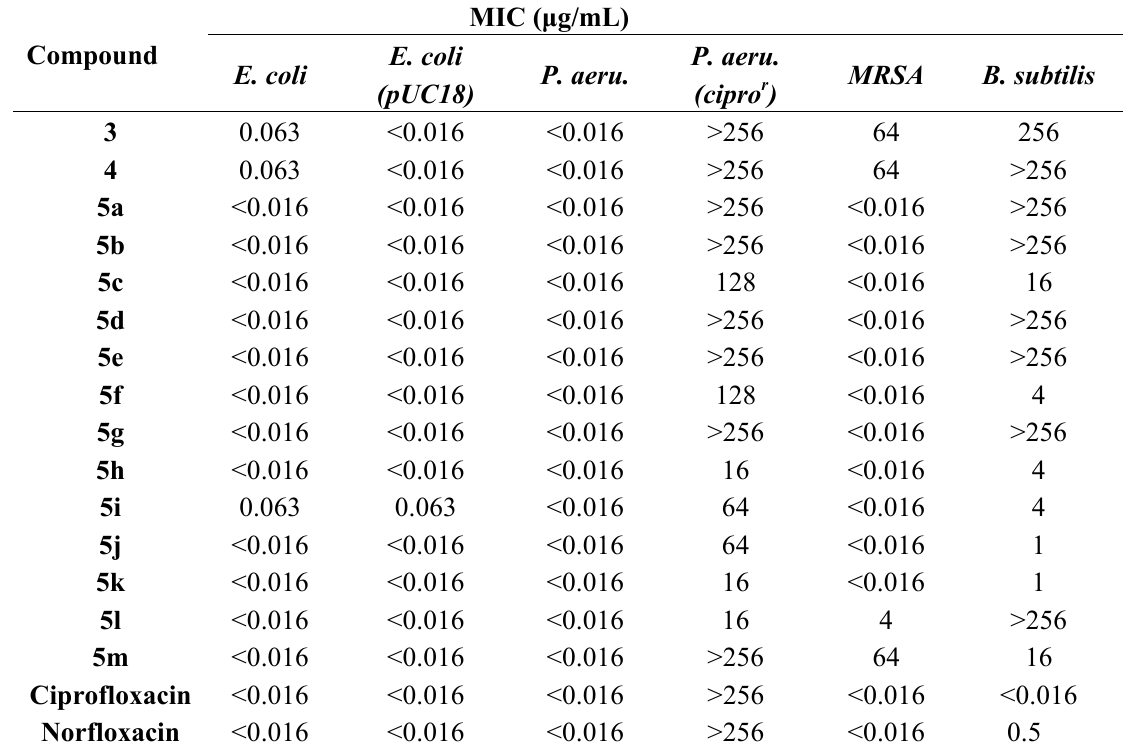
Table 2. In vitro MIC values of ciprofloxacin derivatives against certain G(+)- and G( −